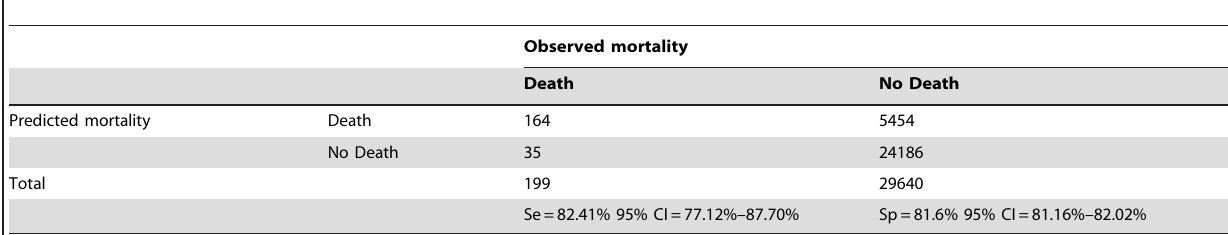
Table 4. Sensibility and specificity (and 95% CI) associated with the classification association rule among the patients selected in the ‘test’ dataset (N =29